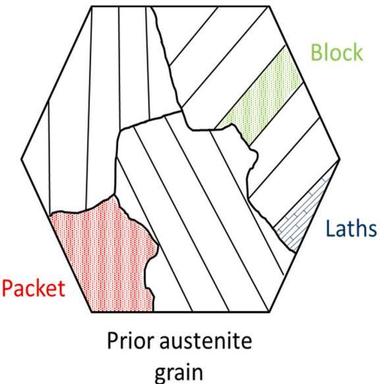
Graphical representation of hierarchical microstructure of bainite.